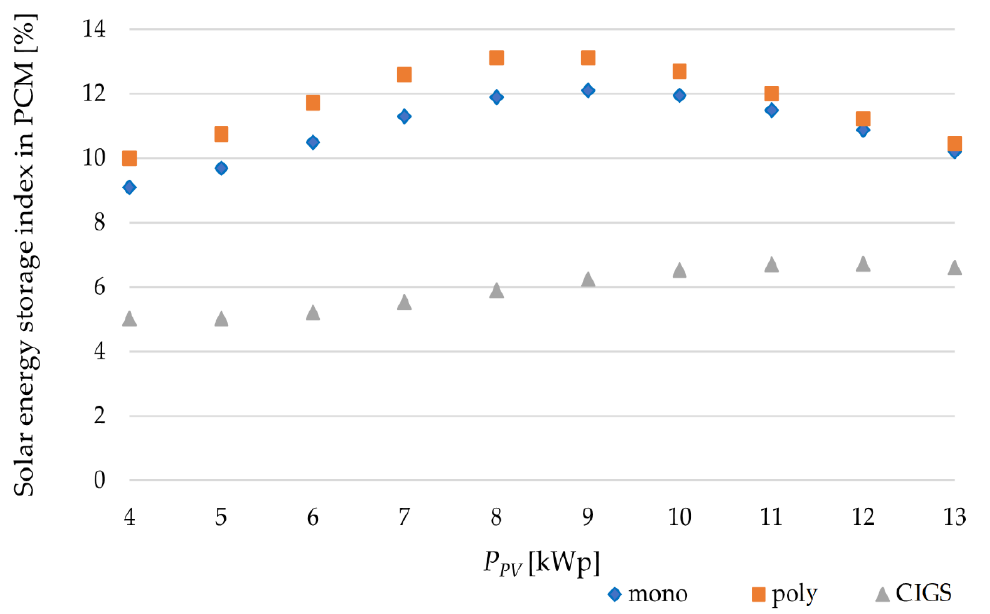
Figure 13. Solar energy storage index in PCM as a function of PV power plant power for sunny days.